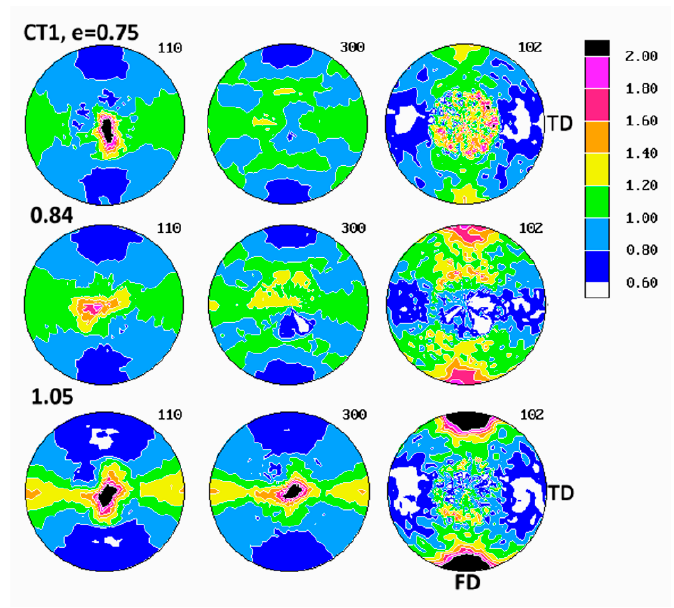
Figure 13. Selected normalized pole figures of the (110) (300) and (102) crystallographic planes (Form I) determined for samples of C1 copolymer drawn in uniaxial tension to the true strain indicated.